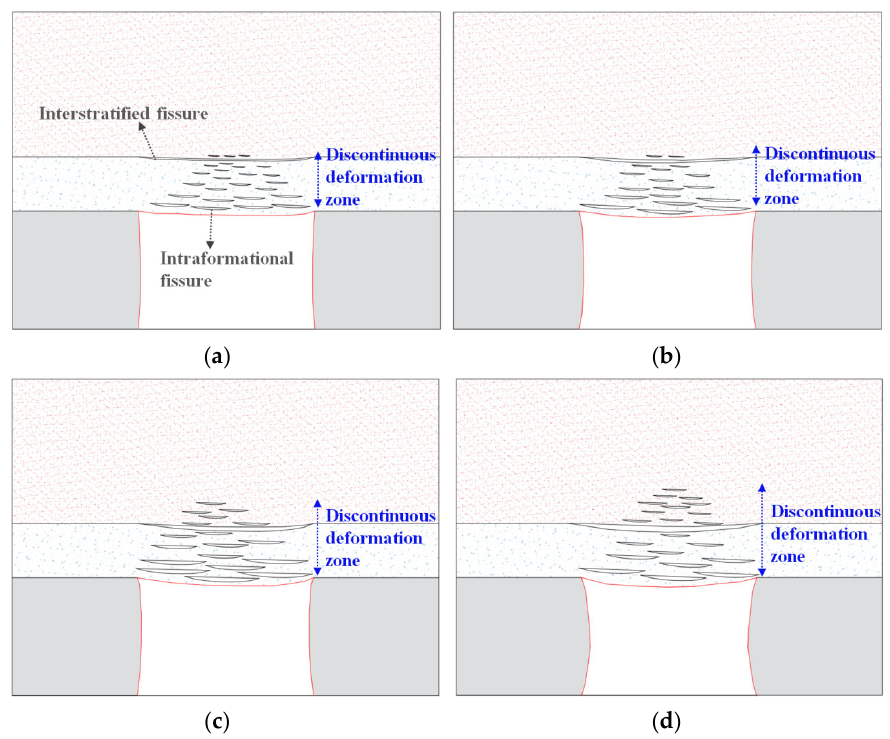
Figure 10. Distribution law of the discontinuous deformation zone of the roadway roof at different buried depths: ( a ) roadway at the buried depth of 200 m; ( b ) roadway at the buried depth of 400 m; ( c ) roadway at the buried depth of 600 m; ( d ) roadway at the buried depth of 800 m.